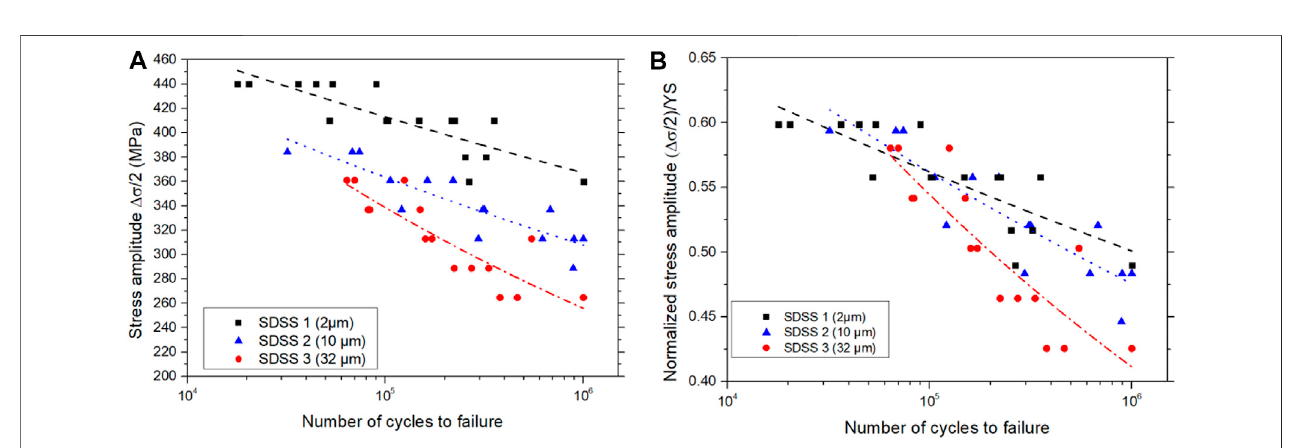
FIGURE 8 | (A) SN curves obtained for SDSS 1, 2, and 3 and (B) normalized by the YS of each alloy.